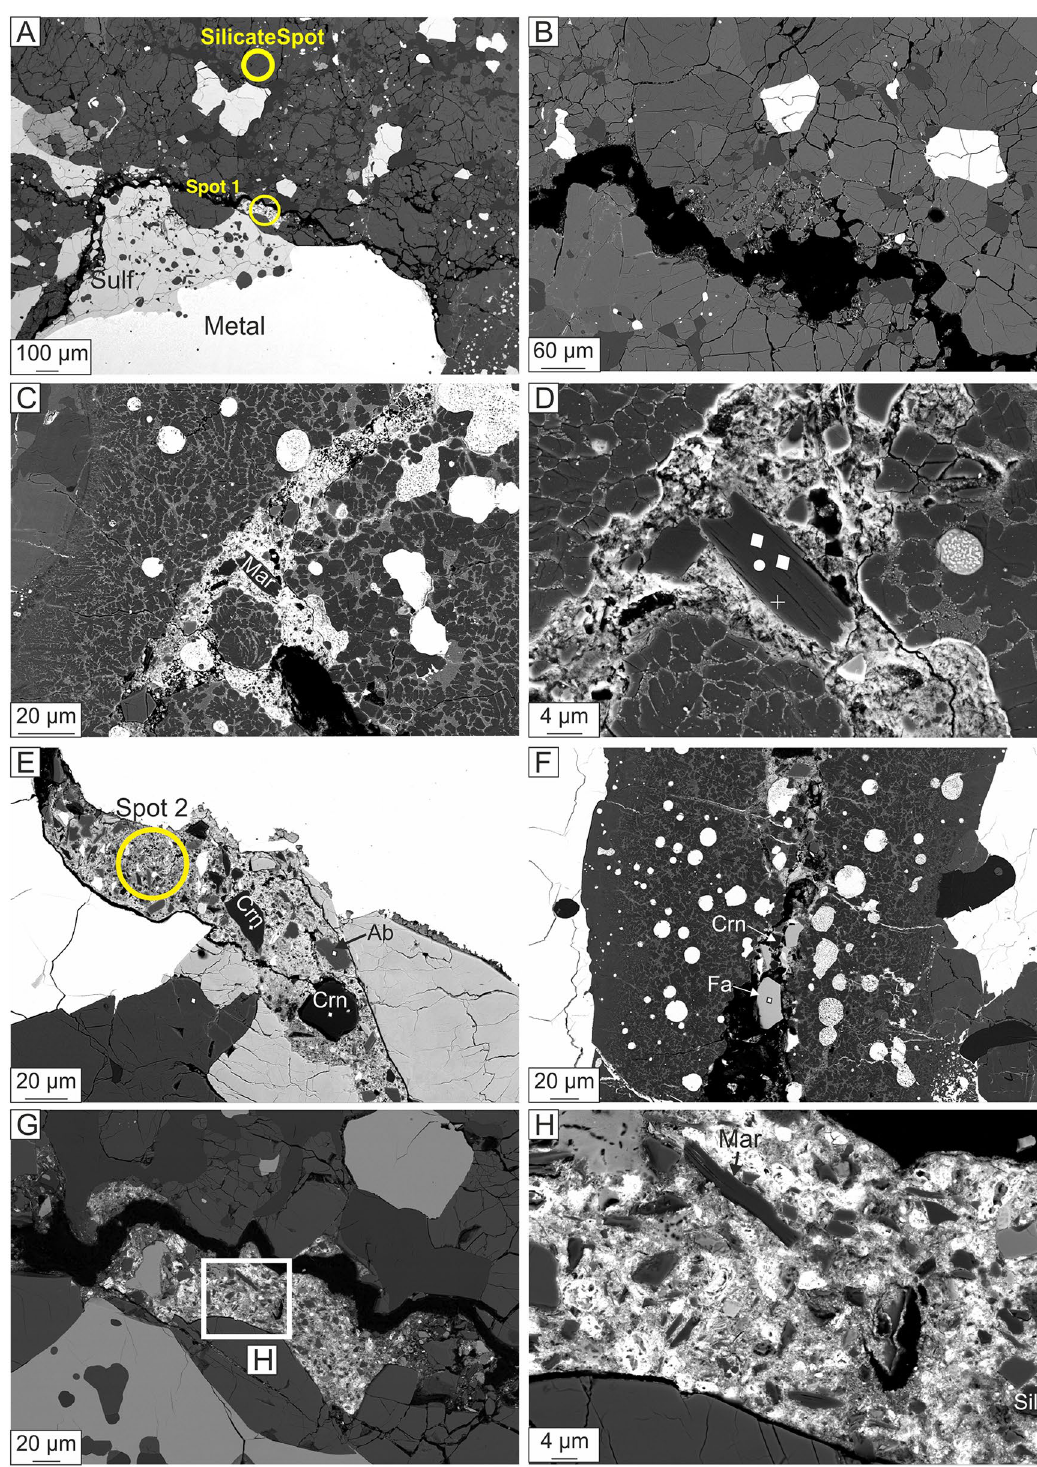
Figure 3. BSE images of the occurrence of exogenous material in Kakowa. ( A ) Overview showing fracture along the edge of a metal- sulfide clast, filled in part with exogenous brecciated material. “Spot 1” and “silicate spot” are areas drilled for Pb-isotope analysis. ( B ) Fracture crossing the groundmass inducing brecciation of the host minerals. ( C ) A fracture that cross-cuts the majorite-rich region of MV1b contains exogenous material including tabular crystals of margarite (Mar). ( D ) Enlargement of the margarite crystal; the white squares indicate the location of nano-SIMS O-isotope analysis points. The white circle indicates the location of margarite Raman spectrum given in Fig. 6A. The white cross indicates the location of margarite EBSD analysis given in Fig. 6C. ( E ) Corundum (Crn) and albite (Ab) in the exogenous material form subhedral to anhedral angular crystals. Spot 2 is a second region of Pb-Fe-rich matrix drilled for Pb isotope analysis. ( F ) Fayalite (Fa) in the exogenous material is also angular. ( G ) Enlargement of the patch of exogenous fracture fill shown in panel ( A ). ( H ) Further enlargement of the same patch showing margarite and a silica (Sil) phase (lower right of the figure) as well as the general texture of angular crystalline grains consolidated in a backscatter-bright